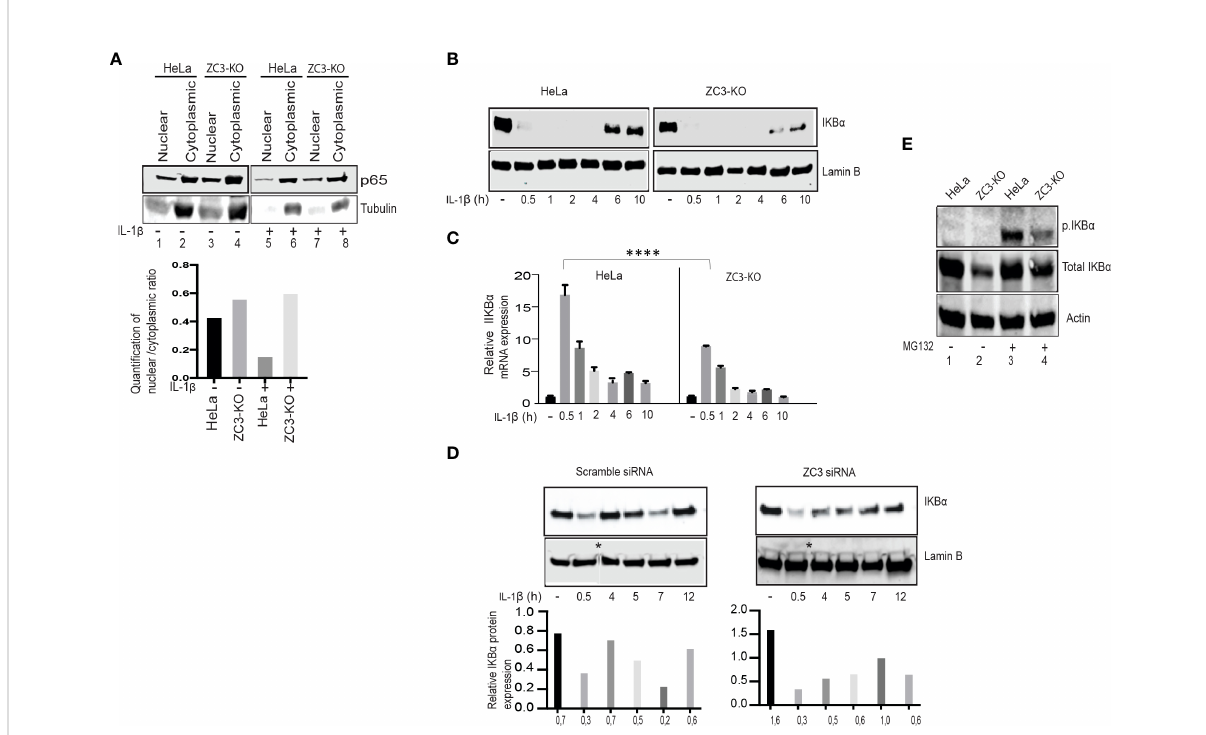
FIGURE 5 ZC3H11A depletion results in defects in I k B a biogenesis. Western blot analysis of the distribution of the p65 protein in the nuclear and cytoplasmic fractions of HeLa or ZC3-KO cells before and after IL-1ß stimulation (A) . Western blot analysis showing the dynamics of total IKBa accumulation after IL-1ß stimulation of HeLa or ZC3-KO cells (B) . RT-qPCR experiment showing the relative expression of the IKBa mRNA under the same experimental conditions as in panel C the data are presented as the mean ± SEM values. , ****p<0.0001; in unpaired t test (C) . Western blot analysis showing the dynamics of total I k B a accumulation after IL-1 b stimulation in HeLa cells transfected with a scramble control siRNA or a ZC3H11A speci fi c siRNA * represents cropped site and that image came from two different blots are pasted together (D) . HeLa or ZC3-KO cells, either treated or not treated with MG132 (5µM, 3 hrs), were probed in a western blot with antibodies detecting phosphorylated or total I k B a (E)